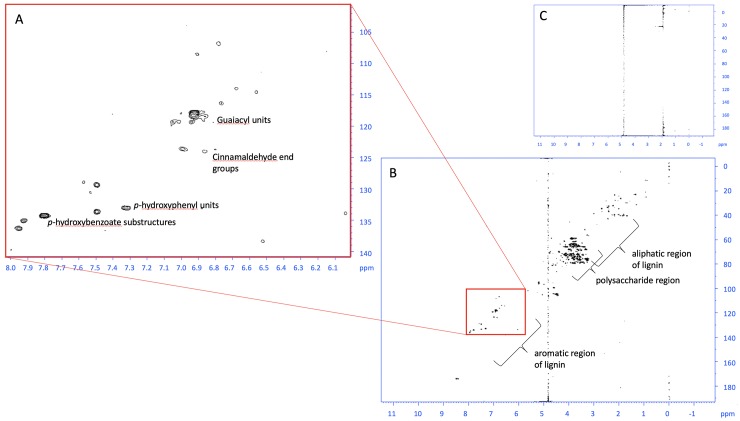
HSQC spectra from EFB sample pre–processed by microwaving at 230°C before (A and B) and after digestion (C). Expansion of the aromatic region is shown in A, showing common lignin polymer linkages, which are no longer observed after AD (C).